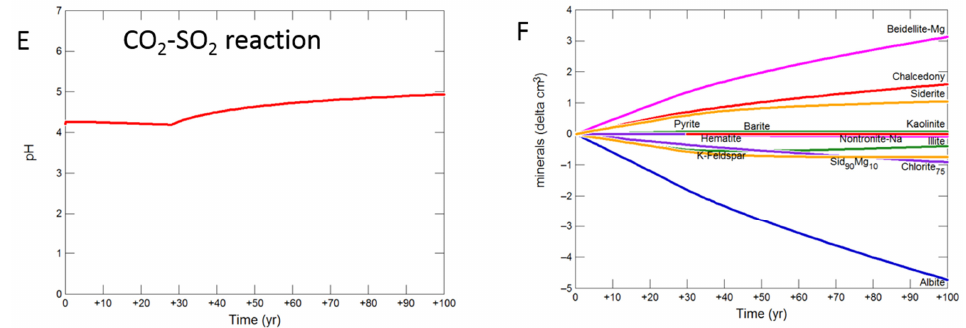
Figure 10. Up ‐ scaled siderite cap ‐ rock reaction over 100 years. Reaction with CO 2 ‐ SO 2 ‐ O 2 ( A ) predicted pH; ( B ) predicted change in mineral volumes (delta cm 3 ) where positive values indicate precipitation, and negative values dissolution; Reaction with CO 2 ( C ) predicted pH; ( D ) predicted change in mineral volumes; Reaction with CO 2 ‐ SO 2 ( E ) predicted pH; ( F ) predicted change in mineral volumes.